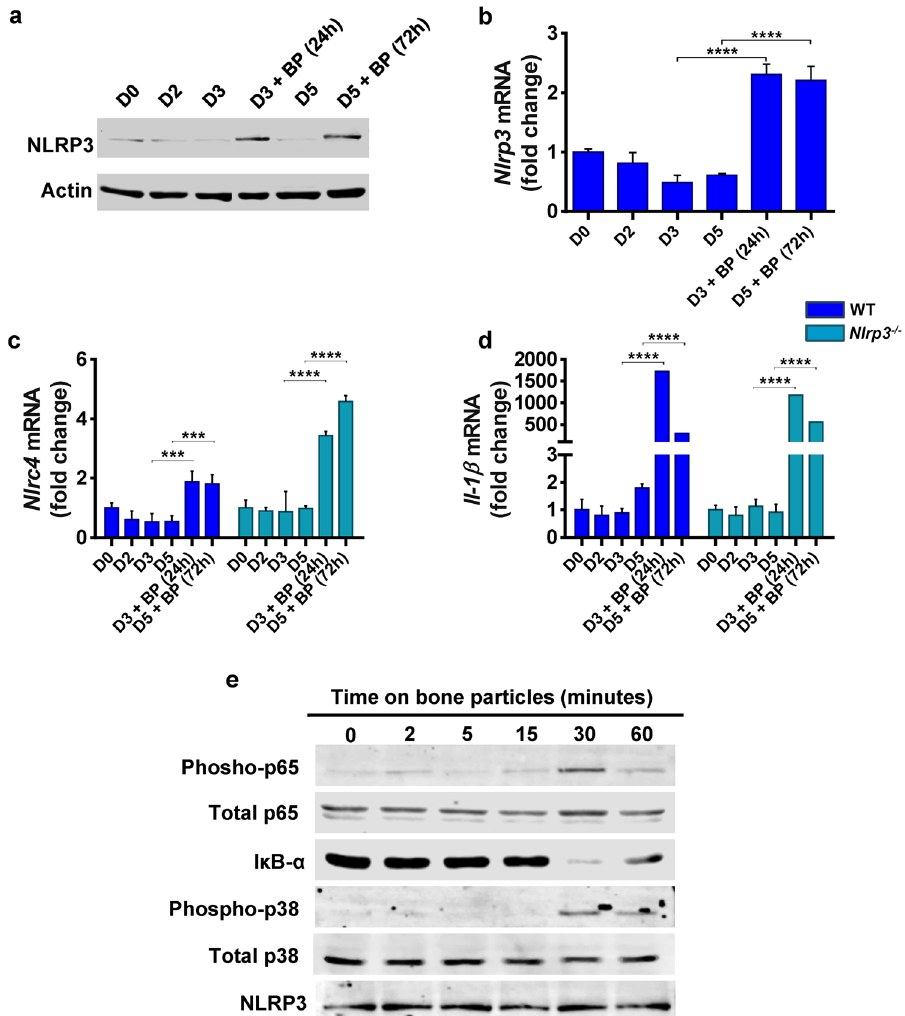
Figure 1. Bone matrix components stimulate the expression of inflammasome constituents. BMM from WT or Nlrp3 − / − mice were incubated with 50 ng/ml RANKL in the presence of CMG as a source of M-CSF. Cells pre-treated with RANKL for 2days (D2) were exposed to bone particles (BP, 125 µ g/ml) or PBS for 24 hours or 72 hours (h). Cells were harvested on D0 (the first day of RANKL stimulation), D2, D3 or D5 and protein and mRNA expression was assessed. ( a ) Western blot analysis of NLRP3 expression. Data are representative of at least 3 independent experiments. Results are from the same gels, but the lanes were cut and pasted (see S1f). ( b – d ) qPCR analysis of mRNA expression. Data are expressed as means ± SD, and are representative of at least 3 independent experiments. ( b ) **** p < 0.0001 (one-way ANOVA and Sidak’s multiple comparison test); ( c ) WT: *** p < 0.0005, Nlrp3 − / − : **** p < 0.0001; ( d ) **** p < 0.0001. ( e ) Western blot analysis of pathway activation. WT BMM were serum-starved overnight and stimulated with 125 µ g/ml BP. Cells were harvested at the indicated time